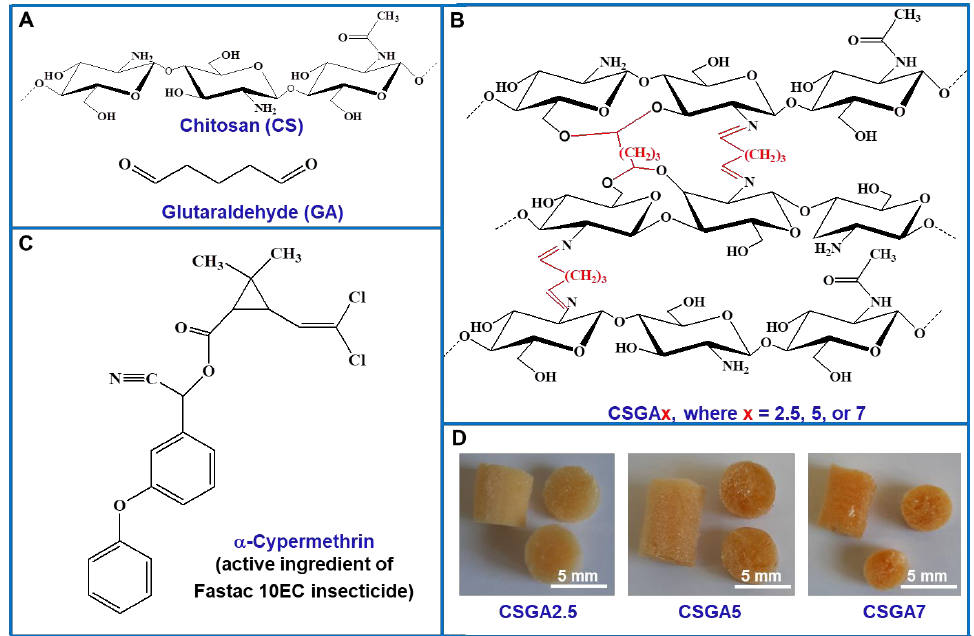
Figure 1. ( A ) Chemical structures of chitosan (CS) and glutaraldehyde (GA). ( B ) Schematic repre- sentation indicating the chemical structure of the cryogel sorbents (the cross-linking with GA is shown in red). ( C ) Chemical structure of α -cypermethrin, which is the active ingredient of Fastac 10EC pesticide. ( D ) Digital optical images of the cryogel sorbents as monoliths, which differed by cross-linking degree ( v / v